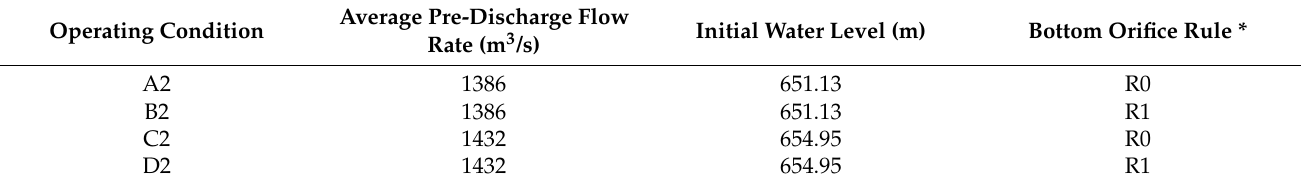
Table 8. Simulated conditions of plug-in model of gate opening scheme in Wudu Reservoir.